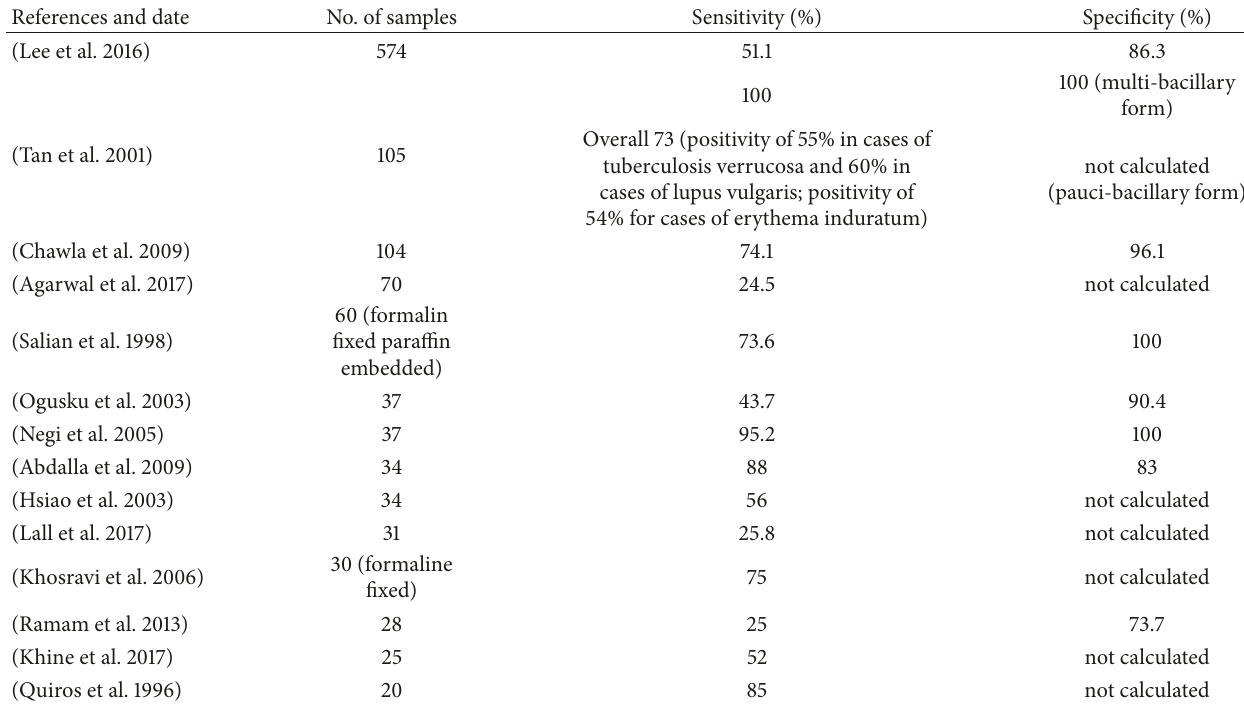
Table 4: Sensitivity and specificity of PCR in the diagnosis of cutaneous tuberculosis (literature